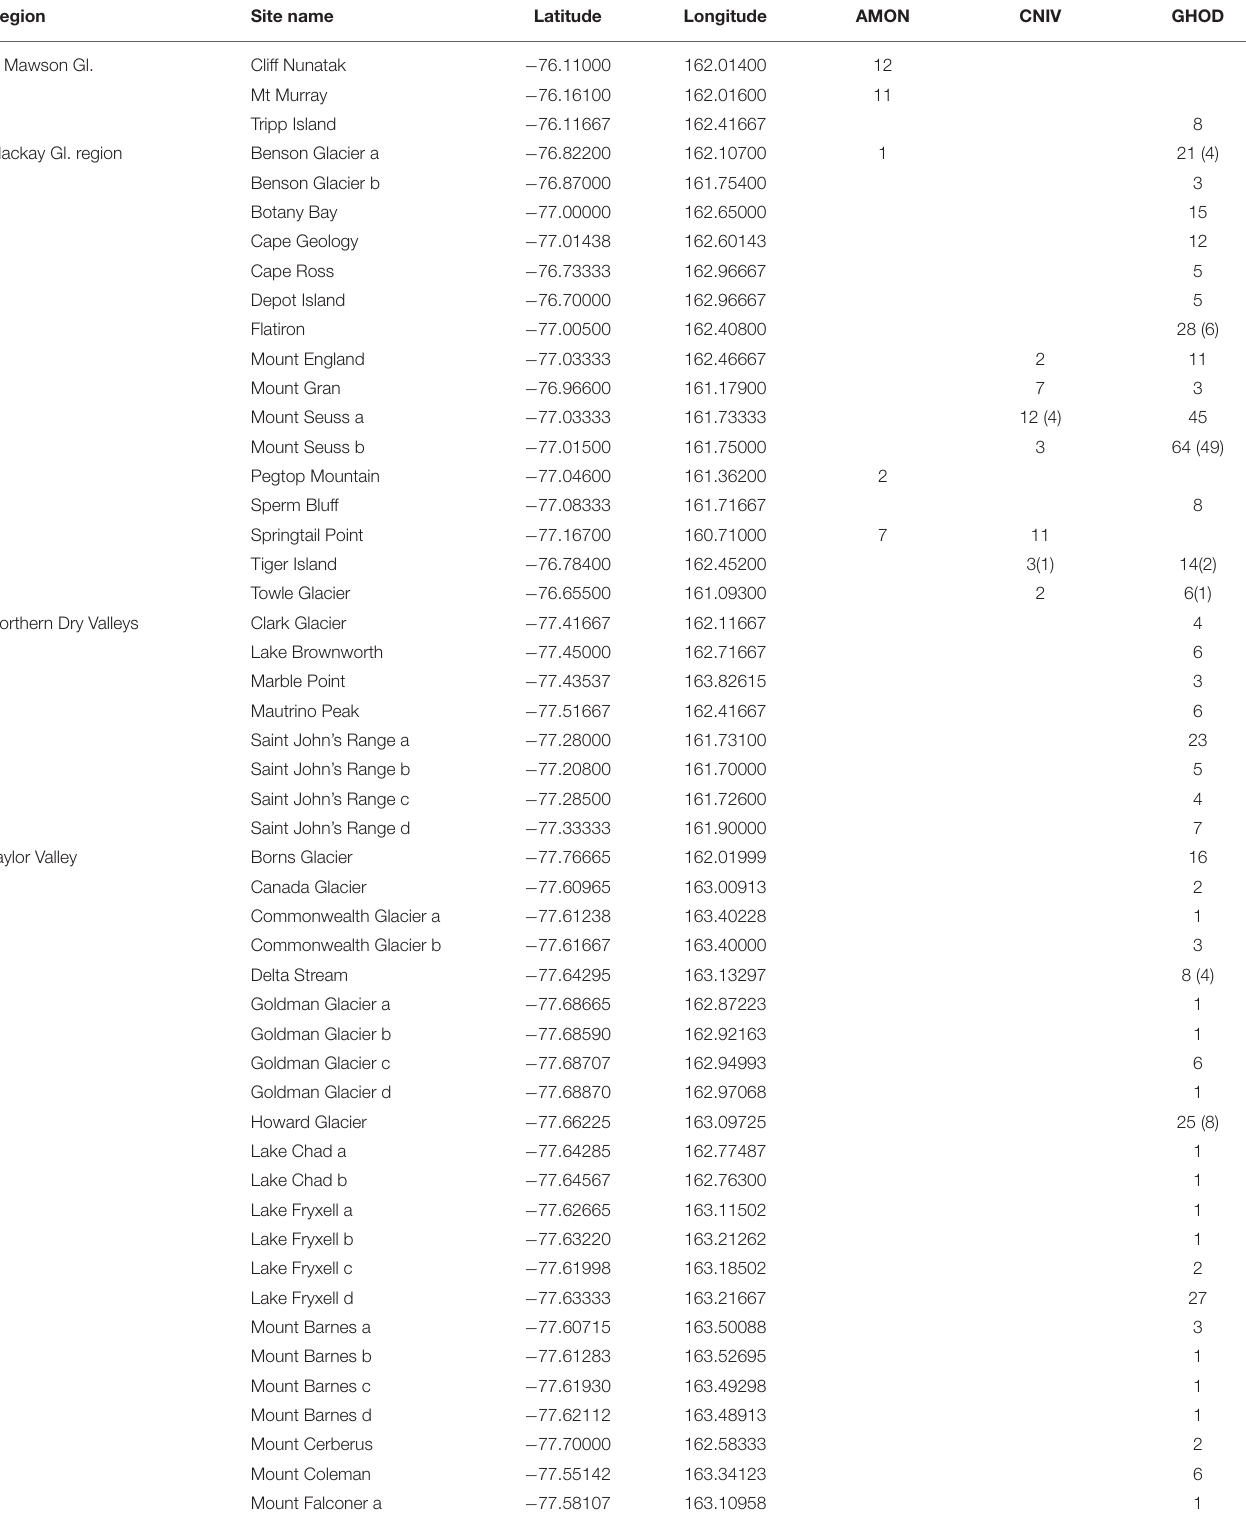
TABLE 3 | List of collection sites in southern Victoria Land, grouped by region, including the number of COI sequences at each site for the three species in this area; Antarcticinella monoculata (AMON), Cryptopygus nivicolus (CNIV) and Gomphiocephalus hodgsoni (GHOD). Region Site name Latitude Longitude AMON CNIV GHOD N Mawson